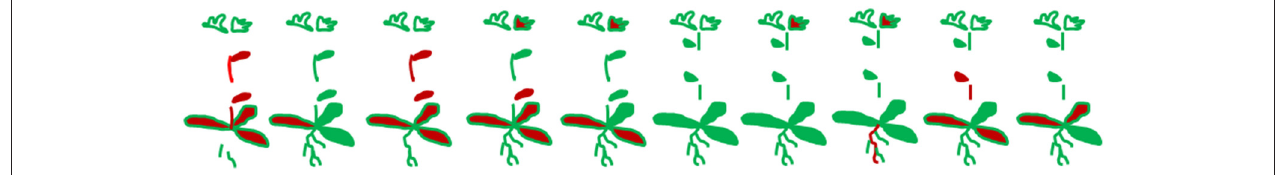
FIGURE 1 | Clustering of recovery of B. cinerea B05.10 from surface sterilized tissues of Arabidopsis thaliana grown in a sterile airflow and inoculated with dry spores at the two leaf stage. Each drawing of a plant represents the samples into which it was dissected. B. cinerea was recovered from samples colored red; note the strong clustering of infected samples in individual plants ( P < 0.001 ).